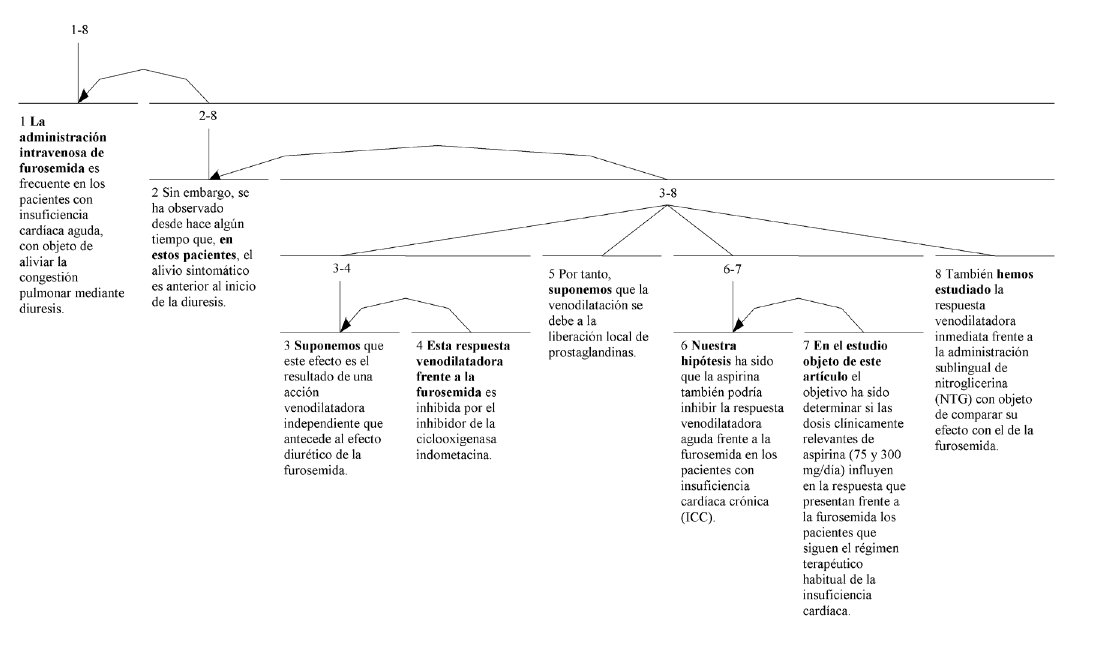
Figure 2. Theme pattern in the Spanish